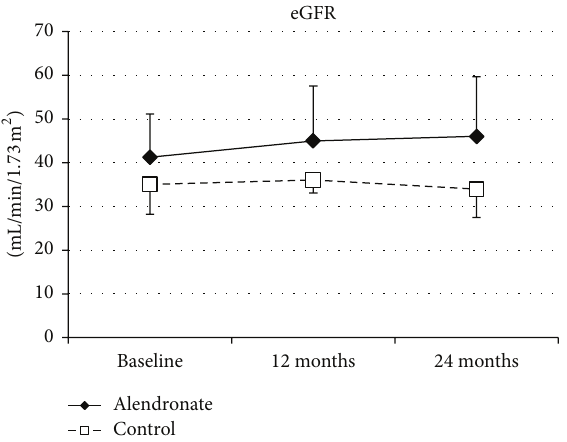
Figure 2: Baseline and follow-up values of parameters in allograft function. eGFR: estimated glomerular function.